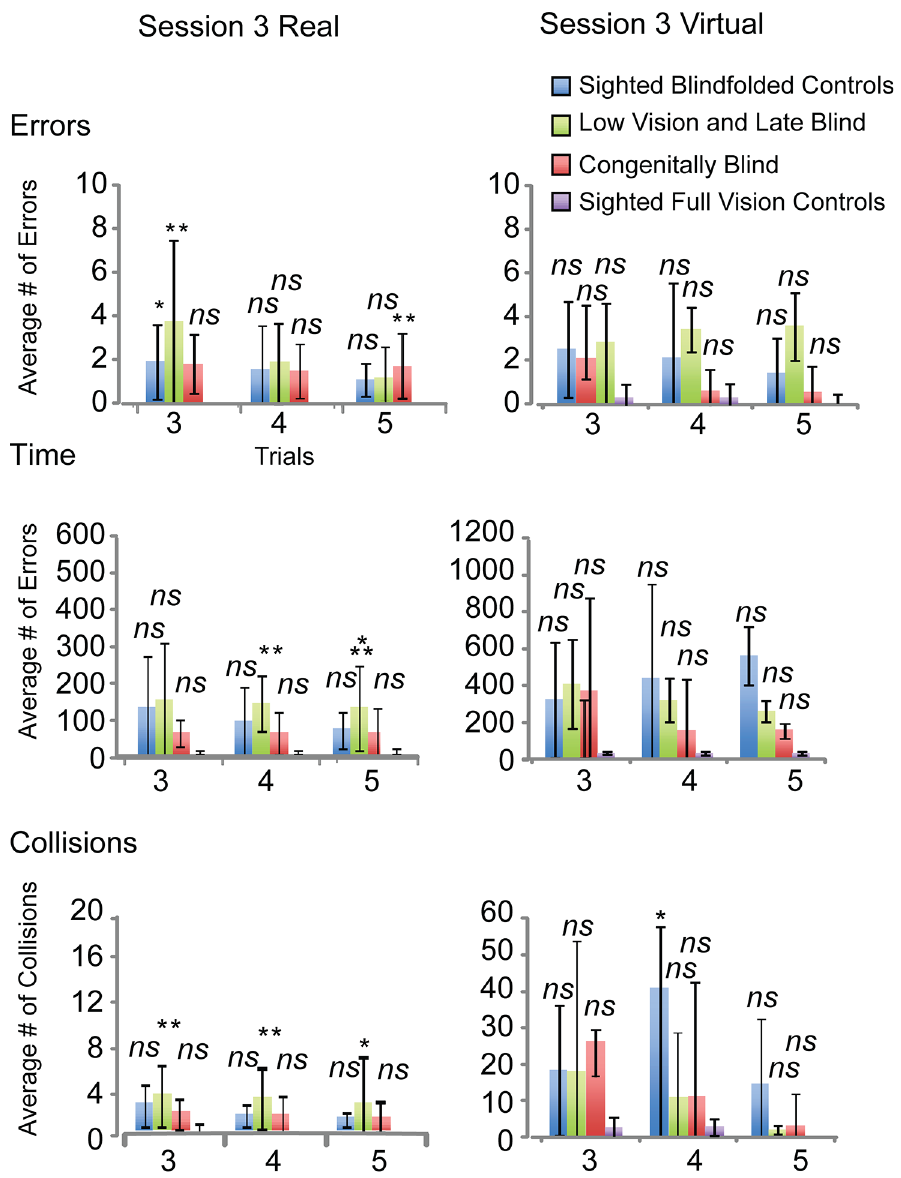
Fig 6. Real and Virtual performances on the last session. Differences between the initial performance of the sighted full vision controls and the other groups on the third session. All statistical comparisons were made with the initial performance of the sighted full vision controls. * p < 0.05; ** p < 0.01; *** p <